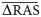
The signal cluster plot in typical allele-specific DNA methylation (ASM) by methylation-sensitive SNP array (MSNP) analysis.(a, b, c) Array data of rs1130368 located around inflammatory bowel disease (IBD) susceptibility gene showing ASM. Rs1130368 is located on the exon of HLA-DQB1 (6p21. 32). (a) All samples, (b) Homozygous samples, (c) Heterozygous samples. Heterozygous changed to homozygous after digestion (ΔRAS¯ = 0.23 was the top score in candidates). This change was monoallelic (G/T changed only T/T); thus, ASM regulated in cis with genotype and not genomic imprinting. This indicated that hypermethylation existed around T allele, whereas hypomethylation existed around G allele. (d, e, f) Array data of rs36221701 located around IBD susceptibility gene showing ASM. Rs36221701 is located on the upstream of SMAD3 (15q22.33). (d) All samples, (e) Homozygous samples, (f) Heterozygous samples. Heterozygous samples tended to change to homozygous after digestion (ΔRAS¯ = 0.14). This change was monoallelic (C/T changed only C/C); thus, ASM regulated in cis with genotype and not genomic imprinting. This indicated that hypermethylation existed around C allele, whereas hypomethylation existed around T allele. RAS, relative allele score.